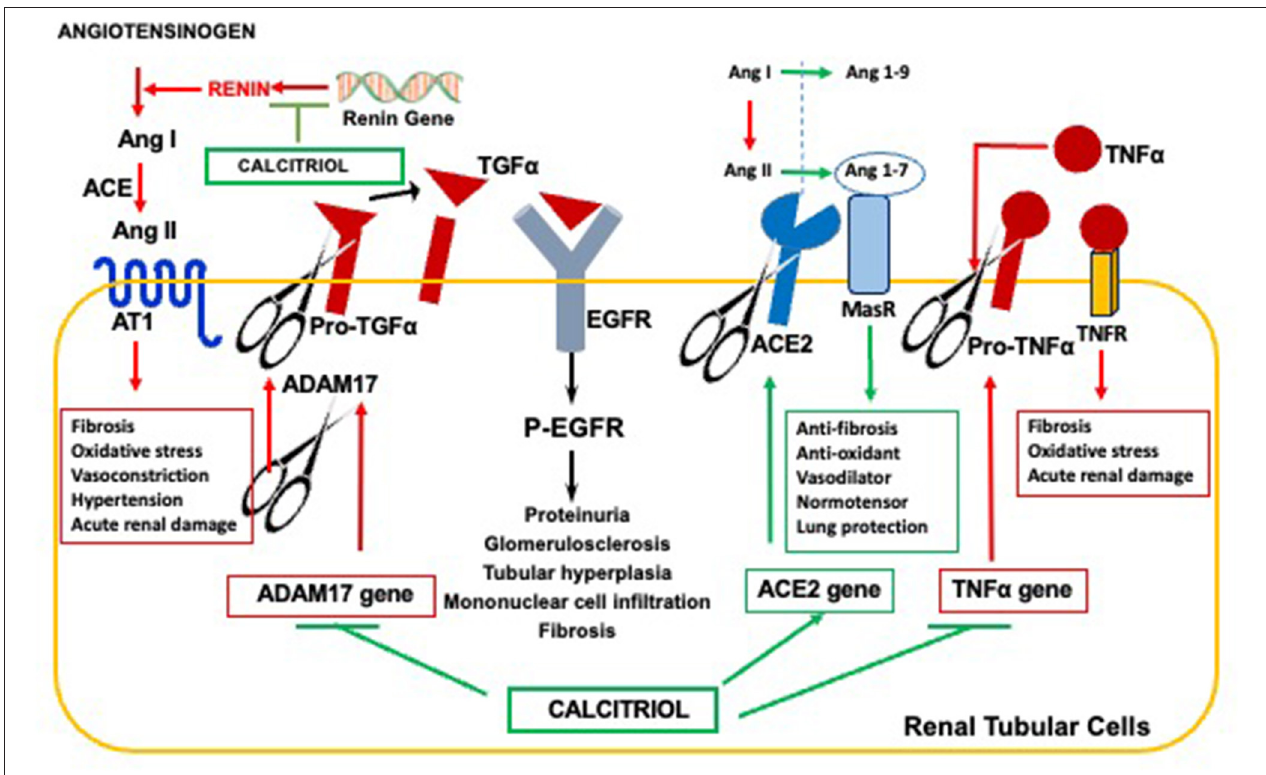
FIGURE 3 | Anti-hypertensive properties of the calcitriol-VDR complex reducing CKD Progression. Calcitriol ameliorates hypertension-driven renal damage by suppression of renin gene expression, responsible for elevations in circulating Angiotensin II; Inhibition of ADAM17 expression to effectively counteract Angiotensin II-mediated increases in TGF α /EGFR signals responsible for CKD progression; Induction of ACE2 for Angiotensin 1-7 synthesis and Angiotenisn 1-7/MAS receptor anti-hypertensive, anti-fibrotic and anti-inflammatory signals, and Inhibition of TNF α expression, whose induction of the ADAM17 gene further augments systemic inflammation and renal